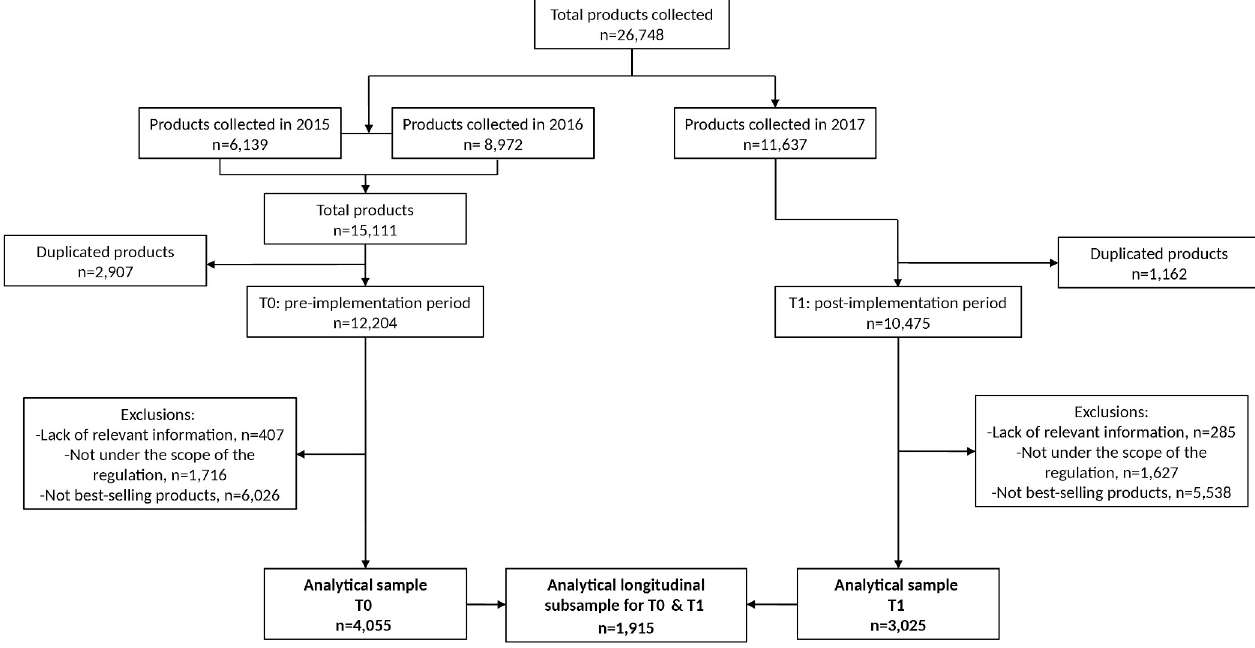
Fig 1. Flow chart describing products excluded from the analytical sample. T0, preimplementation period; T1, postimplementation period.